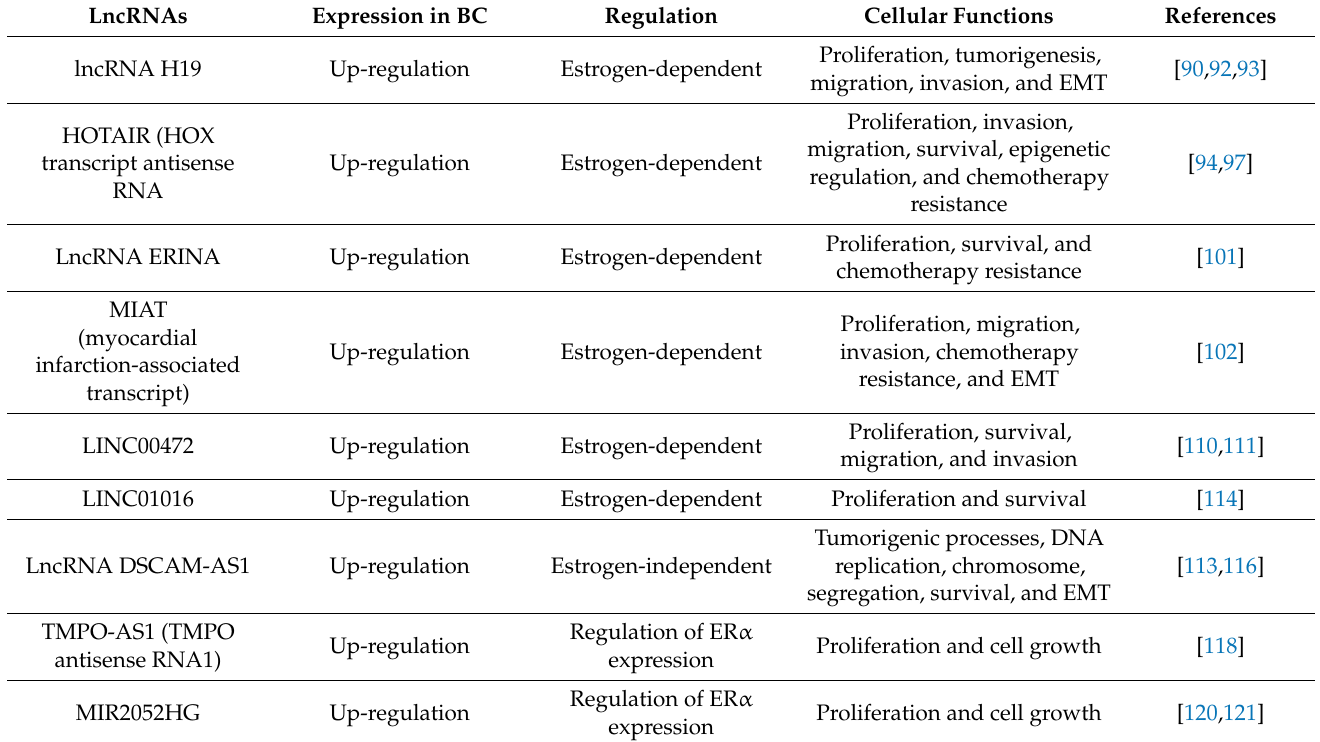
Table 2. Cellular functions of lncRNAs in